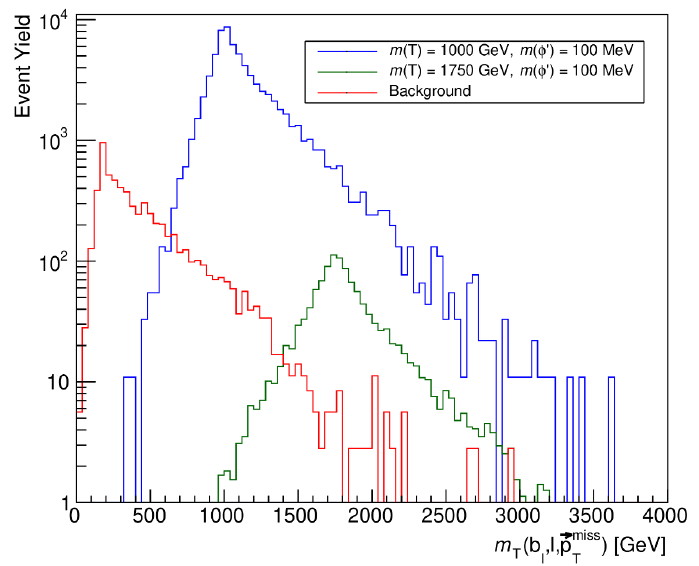
Figure 9 . Distribution of m T ( b ‘ , ‘, ~p miss ) for signal and background (red) after applying selection T cuts on all parameters except m T ( b ‘ , ‘, ~p miss ) , assuming L = 3000 fb − 1 . Two m ( T ) mass points are T shown: m ( T ) = 1000 GeV (blue) & m ( T ) = 1750 GeV (green). In both signal benchmark scenarios, m ( φ 0 ) is 100